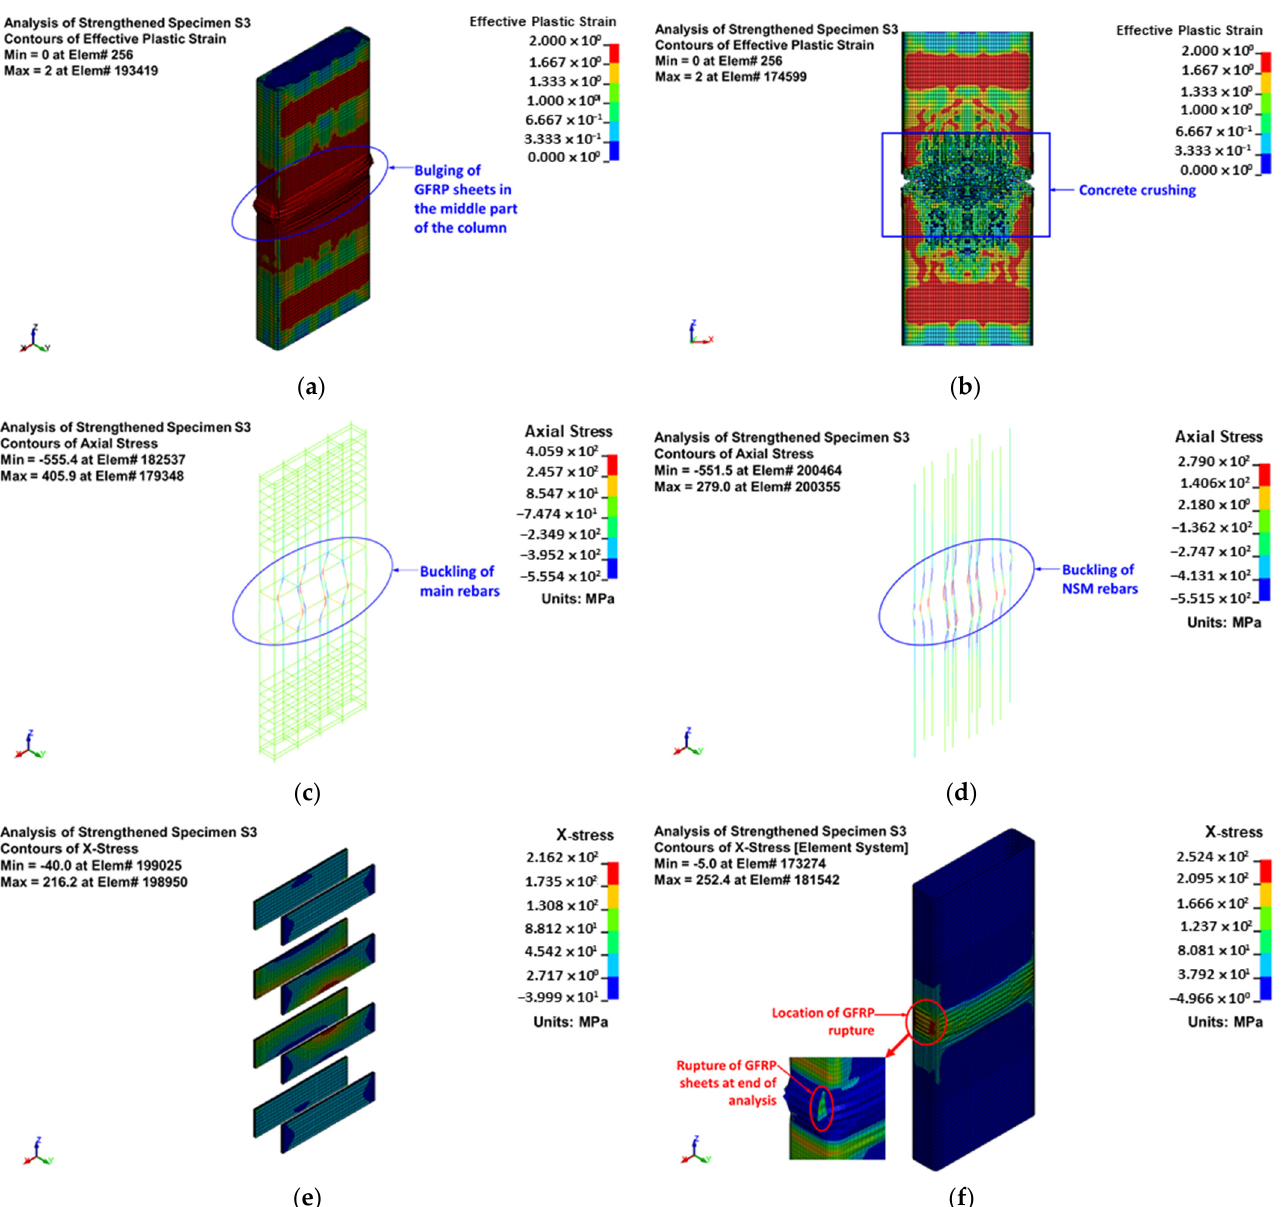
Figure 18. Numerically predicted failure mode for upgraded columns S3 and S4: ( a ) bulging of GFRP sheets at maximum load; ( b ) concrete damage contours; ( c ) stresses in reinforcement cage; ( d ) stresses in NSM bars; ( e ) stresses in steel plates; ( f ) stresses in the fi ber direction for GFRP sheets.